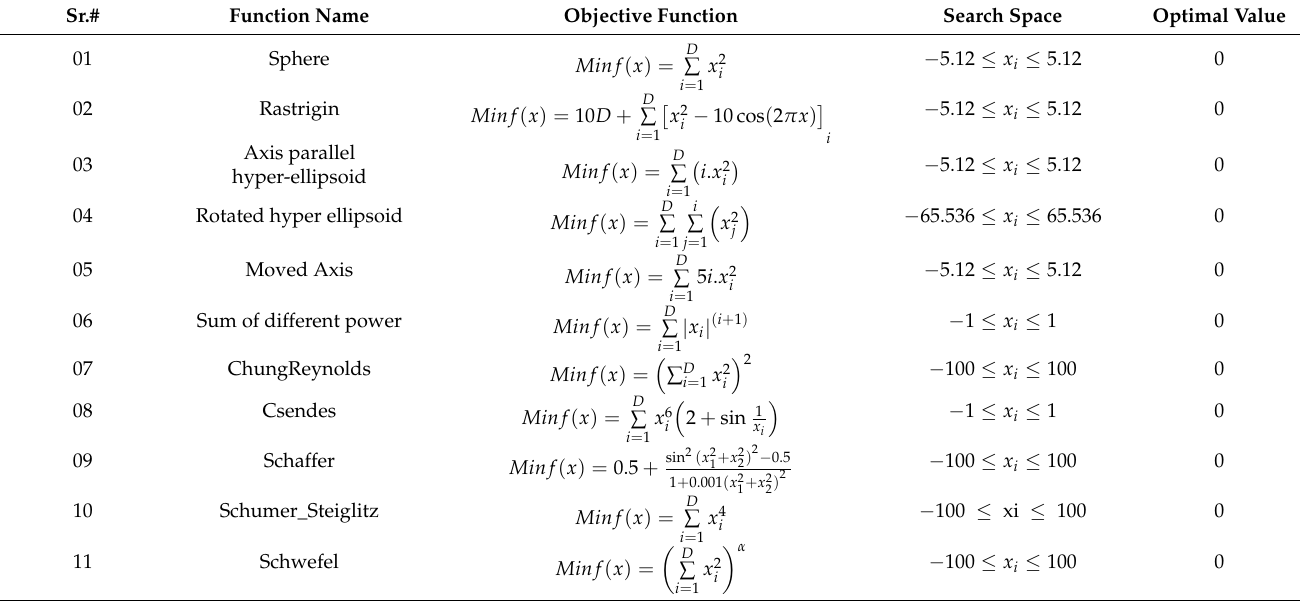
Table 3. Function table with